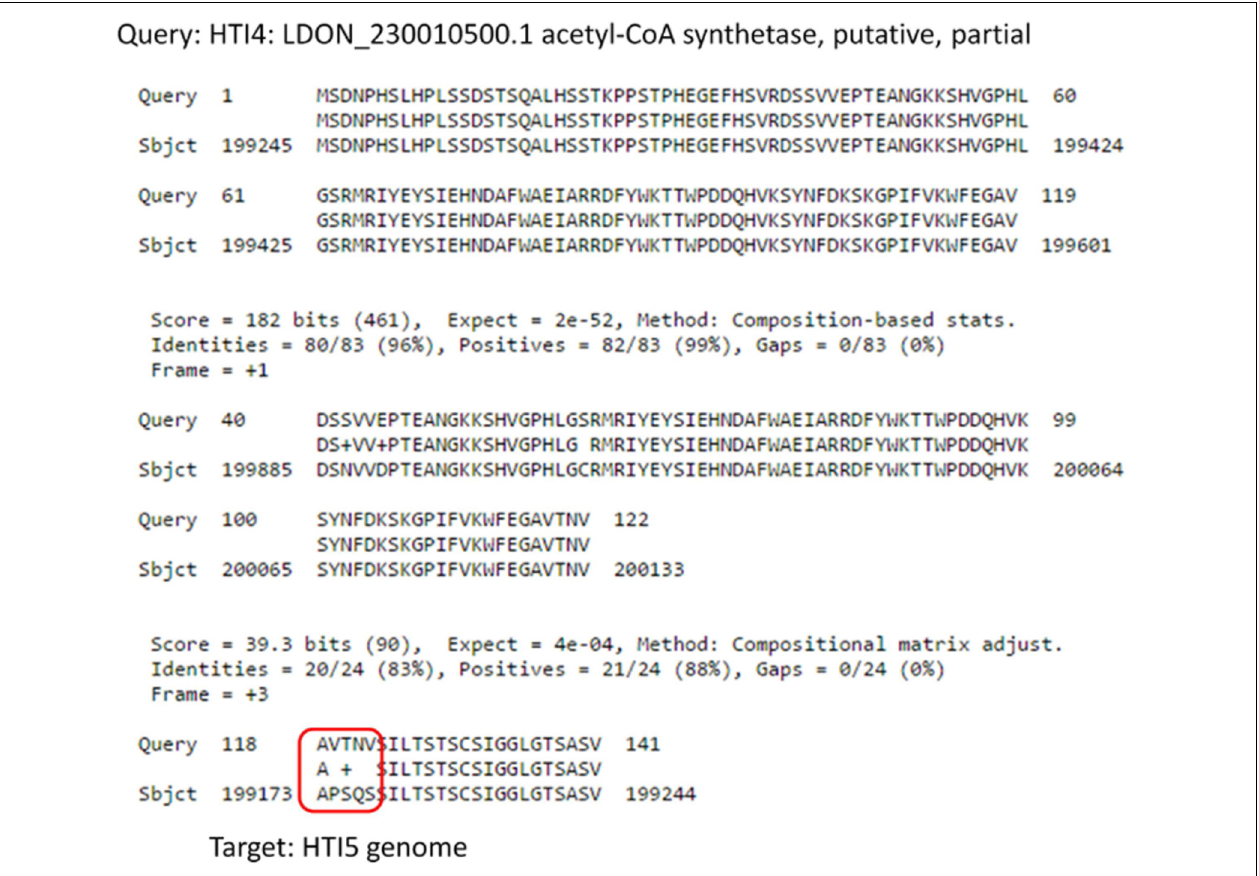
passages and ultimately leads to loss of virulence. Interestingly, multiple members of calpain like cysteine proteases (CALPs) (XLOC_001409, XLOC_000608, XLOC_001023;